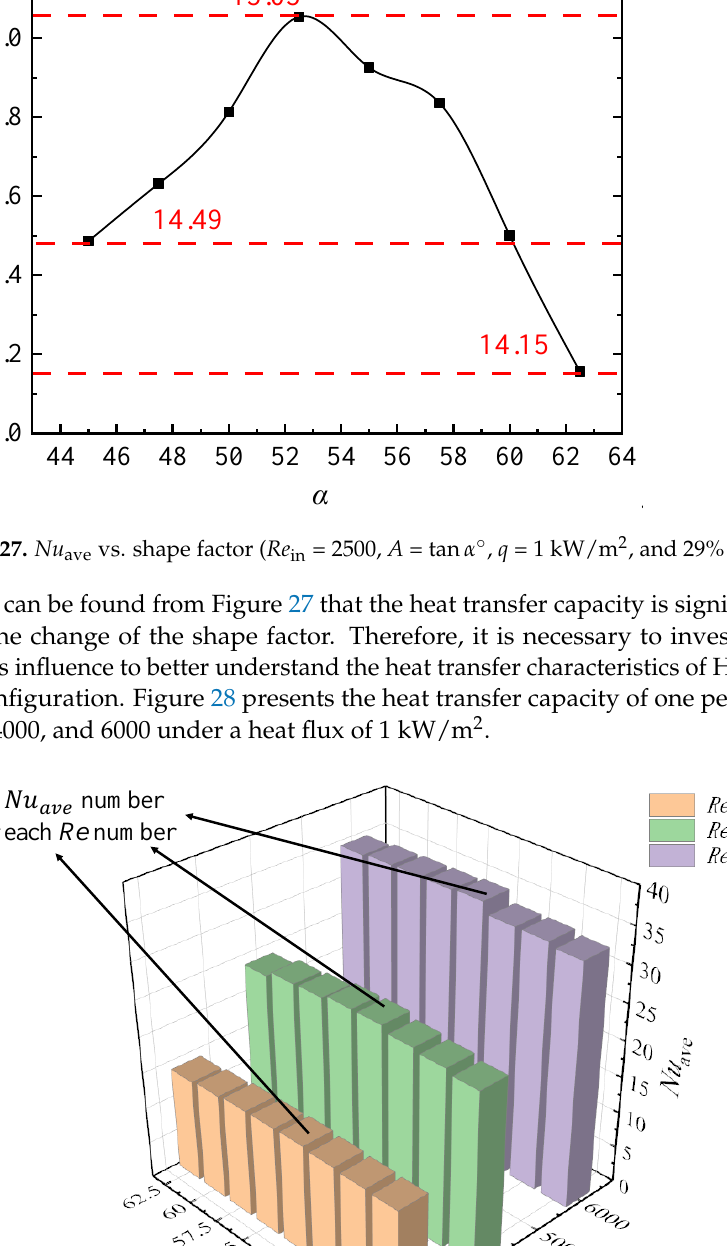
Figure 28. Nu ave vs. shape factor ( Re in = 2500~6000, A = tan 𝛼° , q = 1 kW/m 2 , and 29% Xe).